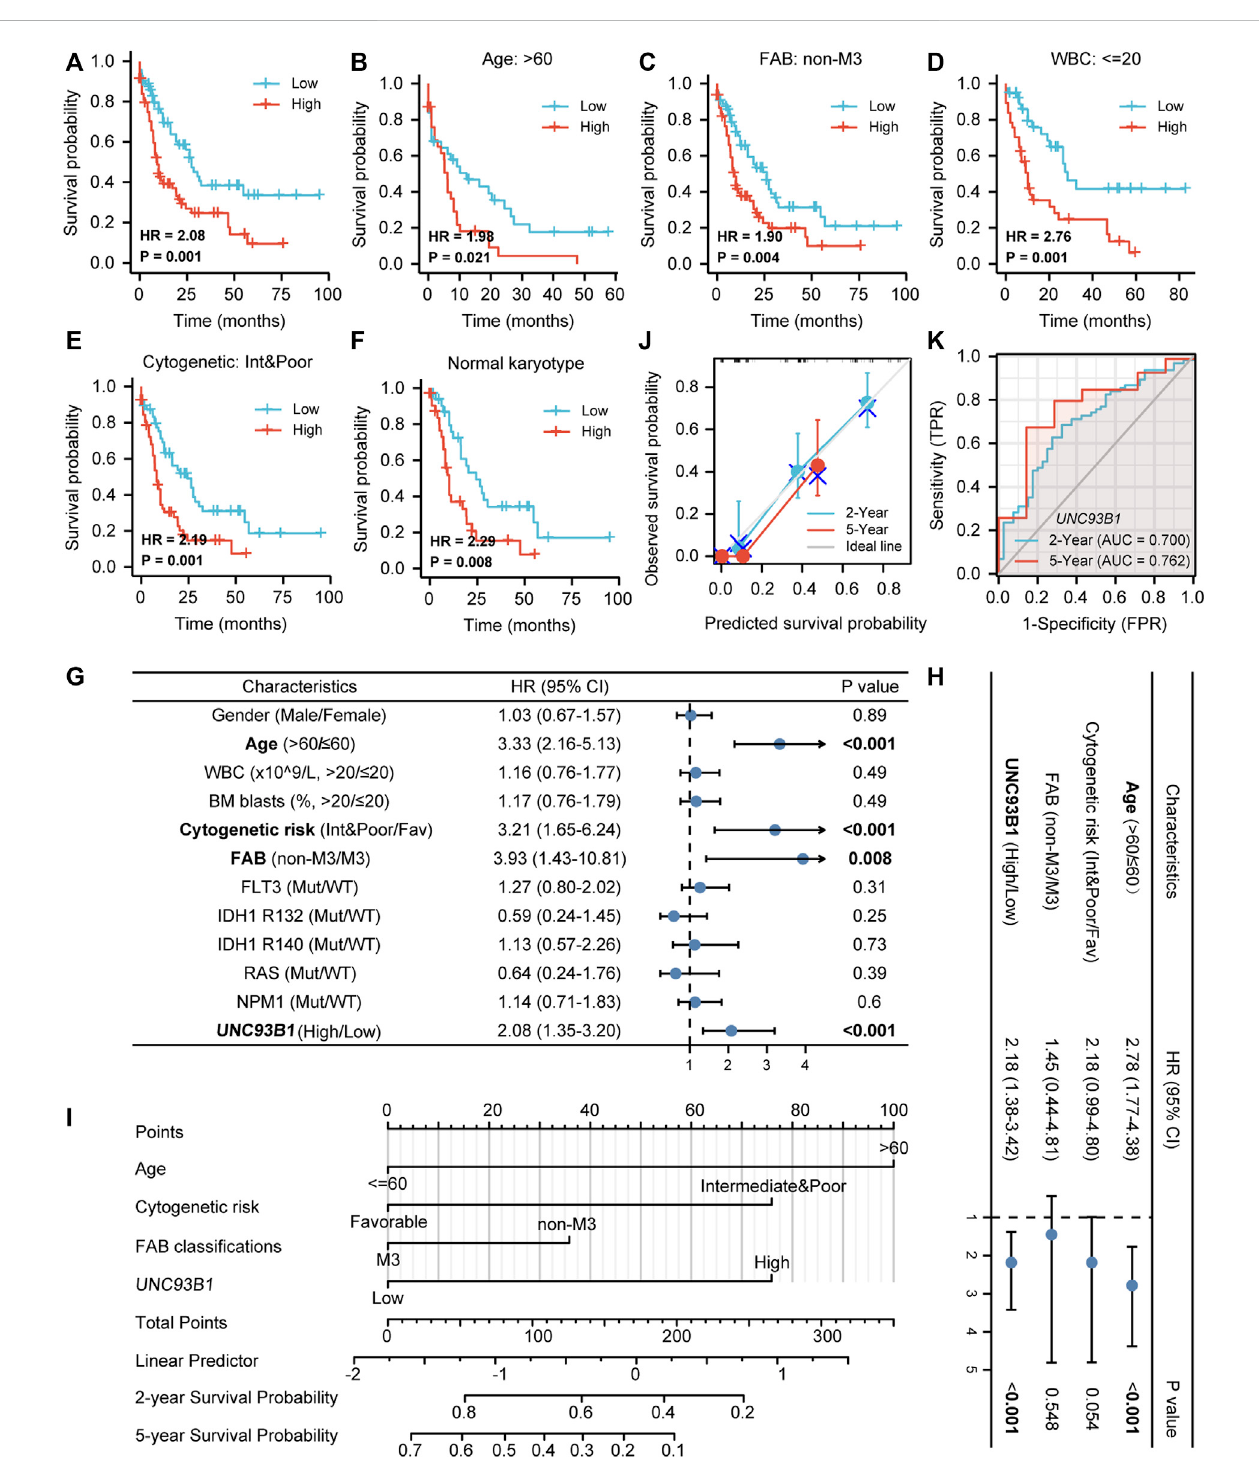
FIGURE 2 Unfavorable prognostic value of high UNC93B1 expression in AML. (A) KM curve analysis of overall survival (OS) between high and low UNC93B1 expression Groups divided by median expression value of UNC93B1 in AML. (B – F) Prognostic value of UNC93B1 expression in each subgroup divided by clinical features. (B) AML patients with age > 60 years old, (C) AML patients with all other subtypes except for M3 according to French-American-British (FAB) classi fi cation, (D) AML patients with WBC counts in peripheral blood < 20 x10 ^ 9/L, (E) AML patients with unfavorable (intermediate and poor) Cytogenetic risk classi fi cation according to 2017 European Leukemia Net (ELN) genetic risk strati fi cation guidelines of AML, (F) AML patients with Normal karyotype. (G) ForestplotofUnivariateanalysesofOS (H) ForestplotofMultivariateanalysesofOS. (I) Nomogrammodelintegrates UNC93B1 andotherprognosticfactorsin AML. (J) Calibrationcurveofnomogram. (K) TheReceiveroperatingcharacteristicanalysis(ROC)by UNC93B1 inpredicting2-yearand5-yearOSofAML.Mut: mutation; wt: wild type; Int: intermediate; Fav: favorable; non-M3 including M0, M1, M2, M4, M5, M6 and M7 of FAB classi fi